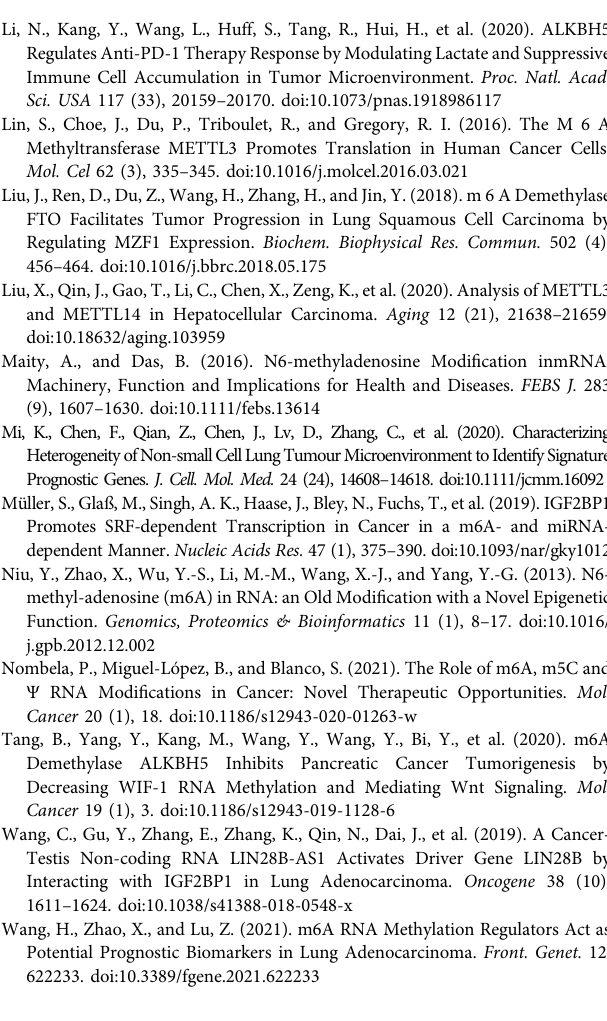
Supplementary Figure 1 | Protein level of IGF2BP1 in LUAD and normal tissues by IHC. Supplementary Figure 2 | Kaplan – Meier survival curves comparing the high and low expression of m 6 A modi fi cation regulators in LUAD using PrognoScan, based on the GEO database (GSE31210) ( n (cid:1)